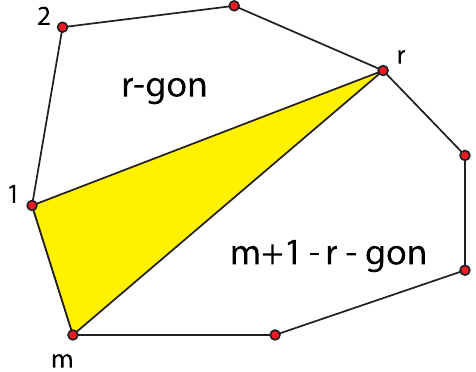
Figure 29. Dividing an m -gon into a triangle, r-gon and ( m + 1 (cid:2) r )-gon.